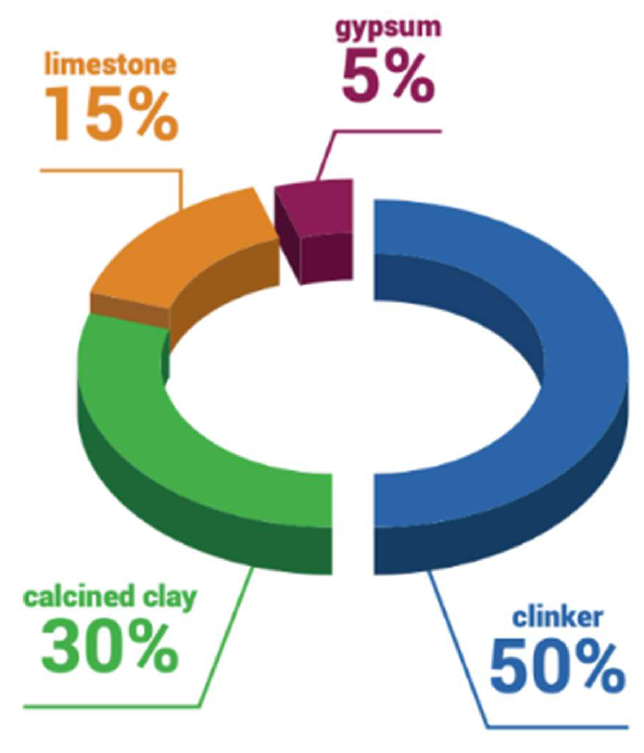
Figure 6. Preparation of LC 3 by blending different constituents.